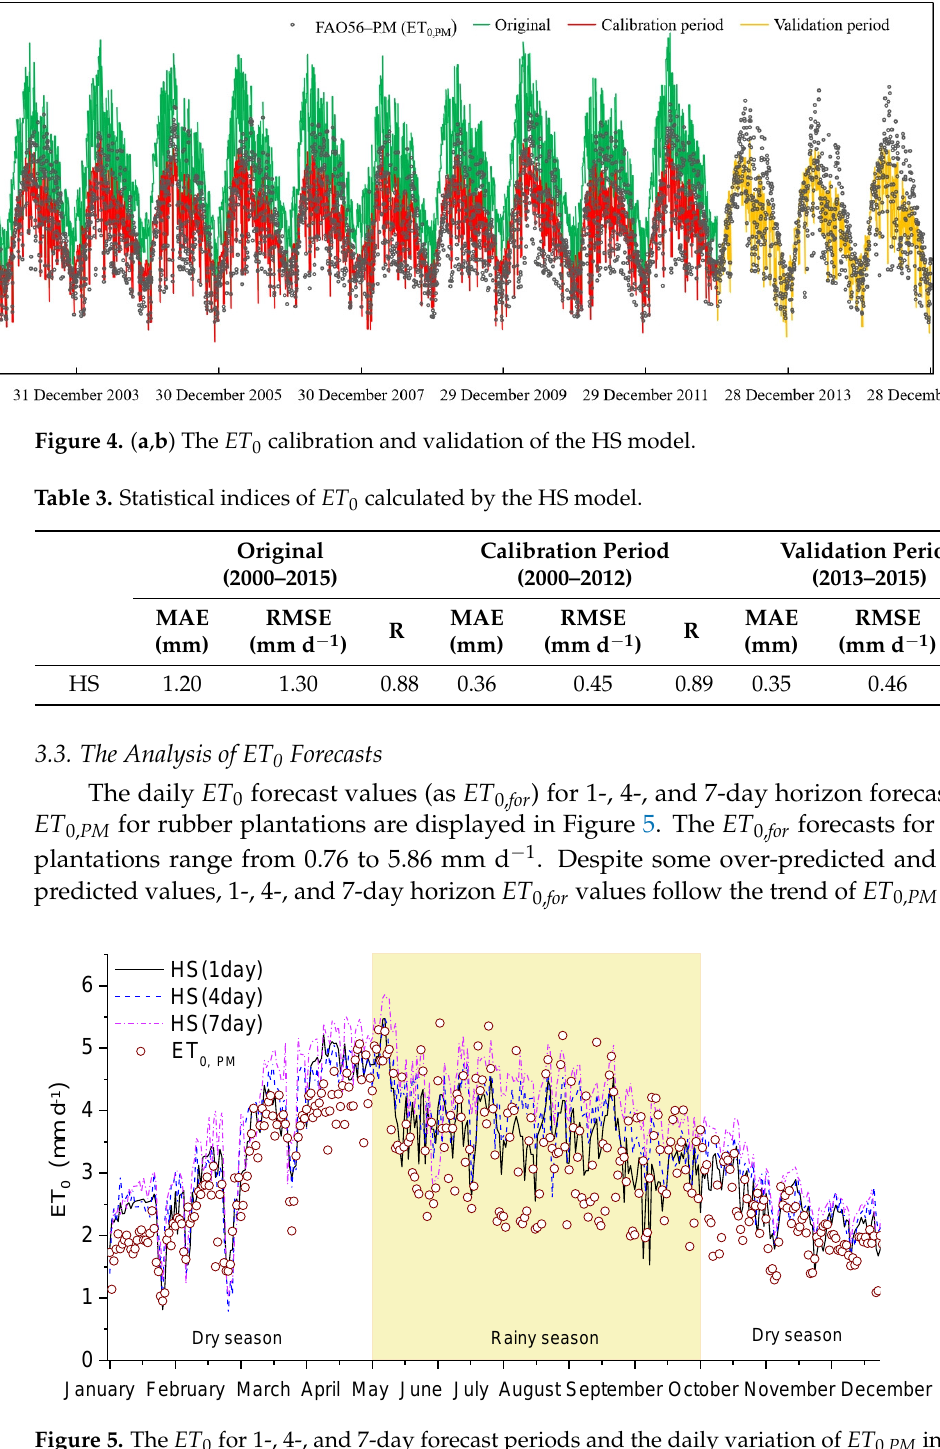
Figure 5. The ET 0 for 1 − , 4 − , and 7 − day forecast periods and the daily variation of ET 0,PM in 2016 (1